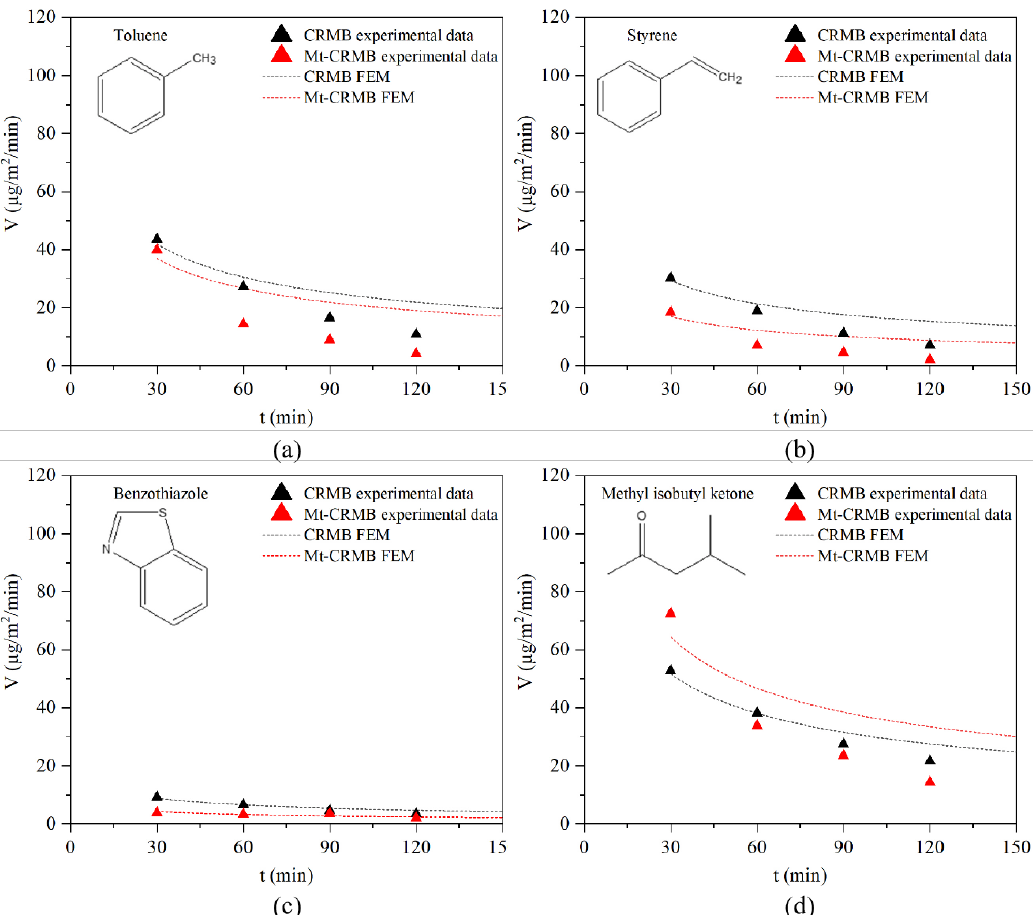
Figure 15. Emission rate of four typical compounds of ( a ) toluene, ( b ) styrene, ( c ) benzothiazole, and ( d ) methyl isobutyl ketone at the upper interface based on the FEM and the experiment. ( d ) methyl isobutyl ketone at the upper interface based on the FEM and the